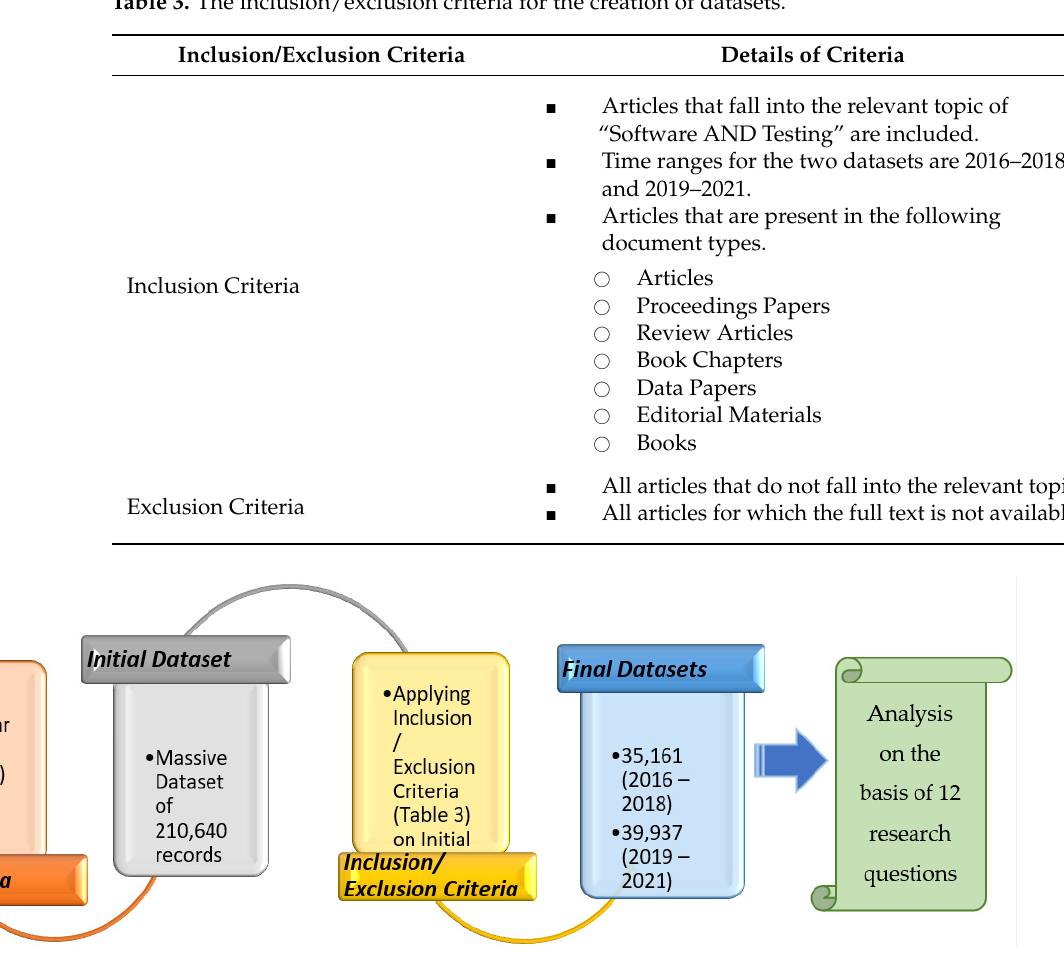
Table 4. Research questions to analyze datasets for 2016–2018 and 2019–2021. Insights